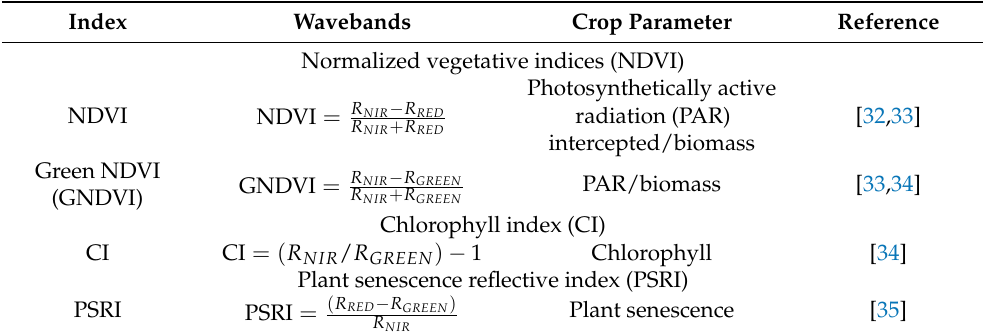
Table 1. Descriptions of the four vegetative indices calculated from aerial images of onion field trials at the Muck Crops Research Station, Holland Marsh, ON in 2015 and